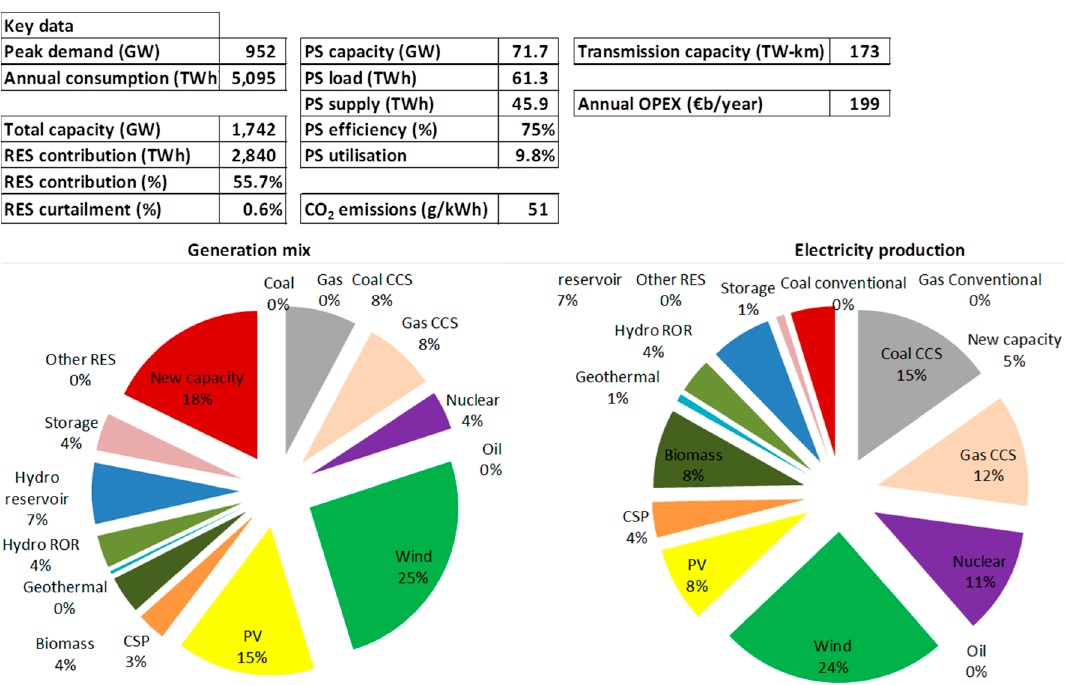
Figure A4. Low RES scenario for 2050.